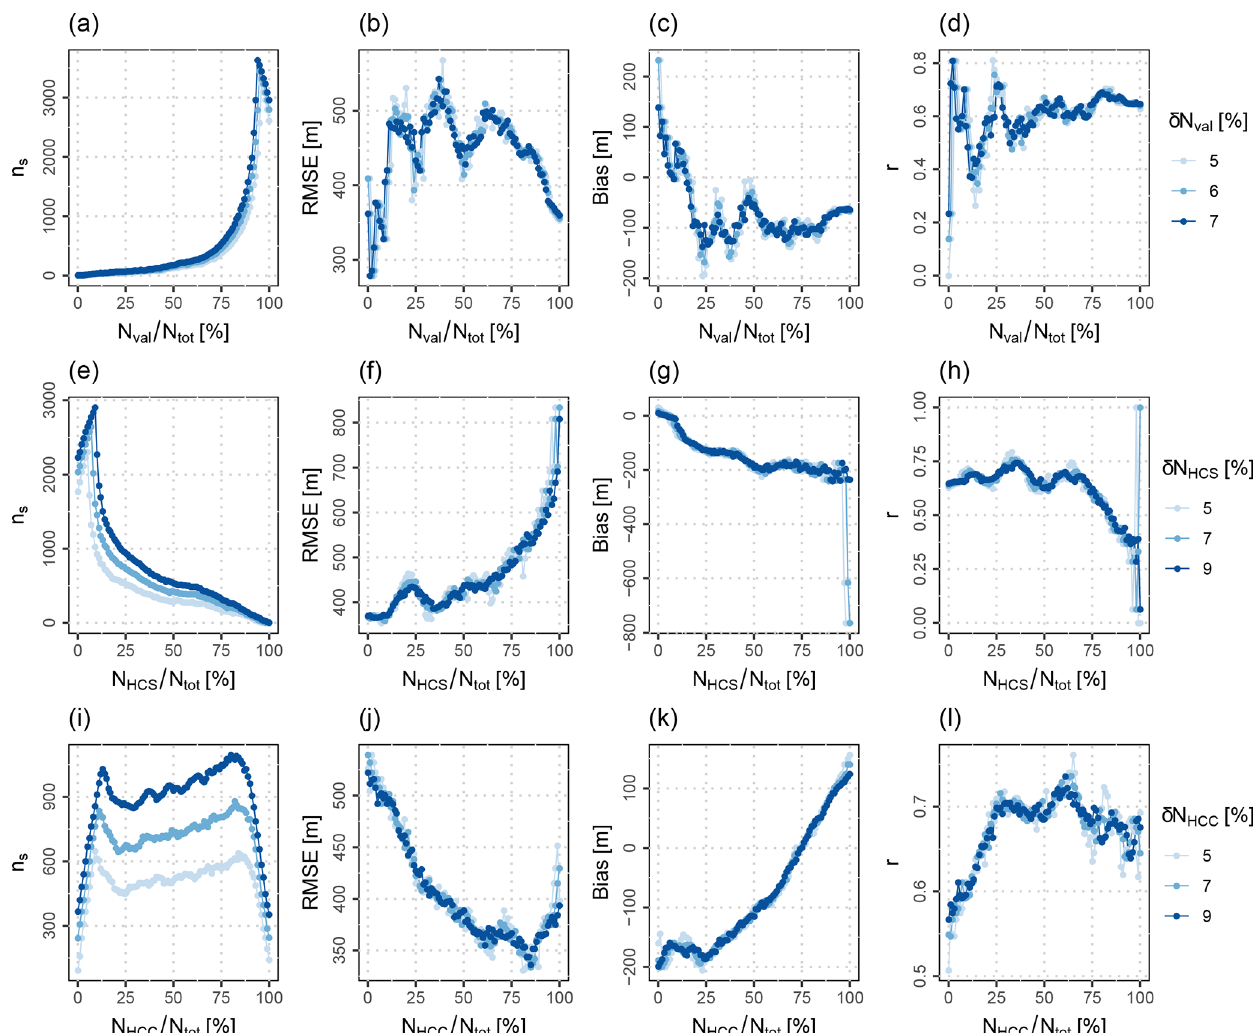
Figure 8. From left to right: number of samples n s , RMSE, bias and correlation coefficient r for the comparison of MIBase and ceilometer retrievals as a function of the number of valid z retrievals N val (panels a–d), the number of retrievals marked as high confidence surface N HCS (panels e–h) and the number of retrievals marked as high confidence cloud N HCC (panels i–l). Each data point is calculated for a subsample which includes only N val ± δN val , N HCS ± δN HCS and N HCC ± δN HCC , respectively. The various widths of the considered N val and N HCC windows are indicated by the blue shading. All values are normalized by the total number of pixels within the MIBase cell N tot . Data are for the year 2008 with R c = 10km, P = 15 and N =